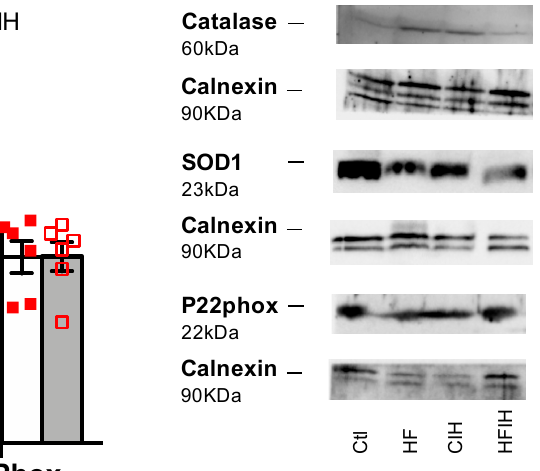
Figure 7. Effect of severe chronic intermittent hypoxia (CIH/IH) exposure on the metabolism of the adipose tissue. ( A ) Effect of severe chronic intermittent hypoxia (CIH/IH) exposure on adipose tissue (97 kDa) and glucose transporter GLUT4 (54 kDa) immunoreactivity in control and HF animals in relation to the expression of the loading protein, calnexin. ( B ) Effect of severe CIH on peroxisome proliferator-activated receptor γ (PPAR γ ) (53 kDa) and perilipin A (60 kDa) immuno- reactivity in control and HF animals in relation to the expression of the loading protein, calnexin (90 kDa). Representative Western blots for each protein studied are depicted in the right panel. Data are presented as means ± SEM of 5–8 animals. One- and two-way ANOVA with Dunnett’s and Bonferroni multiple comparison tests, respectively: * p < 0.05 and ** p < 0.01, compared with control animals; ## p < 0.05 compared values with HF animals without CIH.